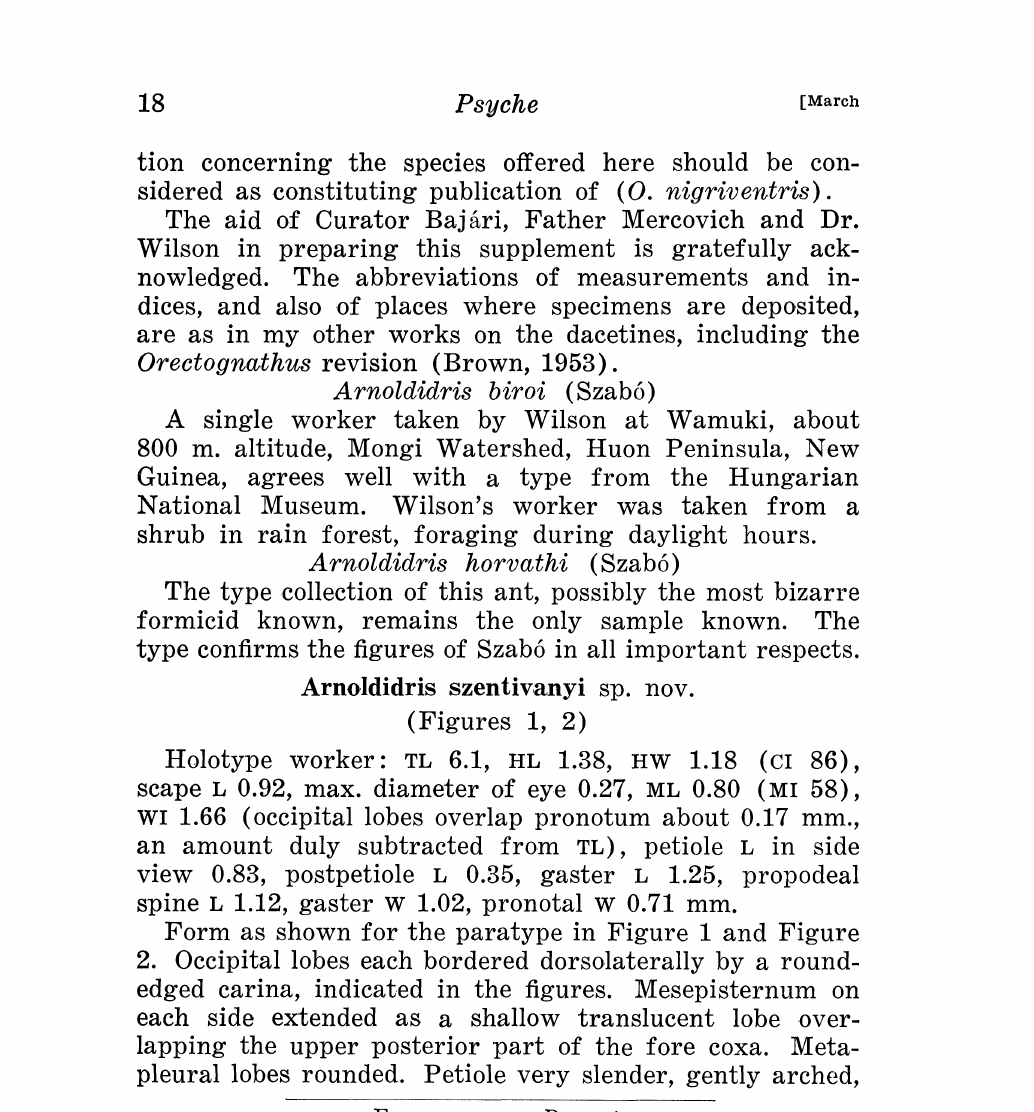
to 4. Figure 1, Arnoldidris szentivanyi sp. nov., paratype worker, dorsal view. Figure 2, same, side view of posterior half of head. Figure 3, (Orectognathus nigriventris Mercovich ms.), worker from type series, dorsal view of half of head. Figure 4, O. phyllobates sp. nov., holotype worker, dorsal view. All to same scale. Drawings by Nancy